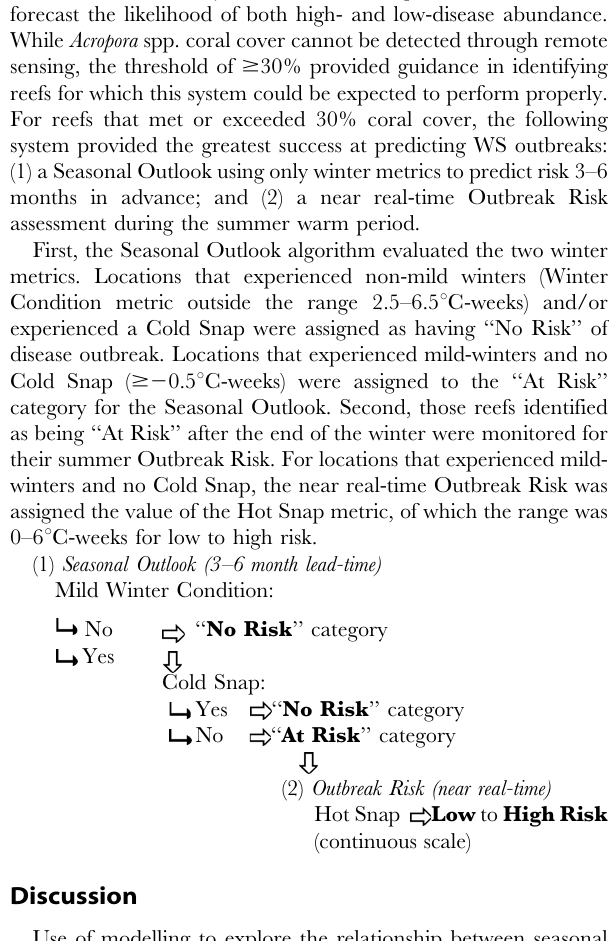
Figure 4. Variation in white syndrome disease counts with coral cover and 4 km satellite metrics. The symbol shape and colour indicate whether Acropora spp. coral cover was low: , 30% (open orange circle), or high: $ 30% (violet square). Dashed lines indicate the outbreak